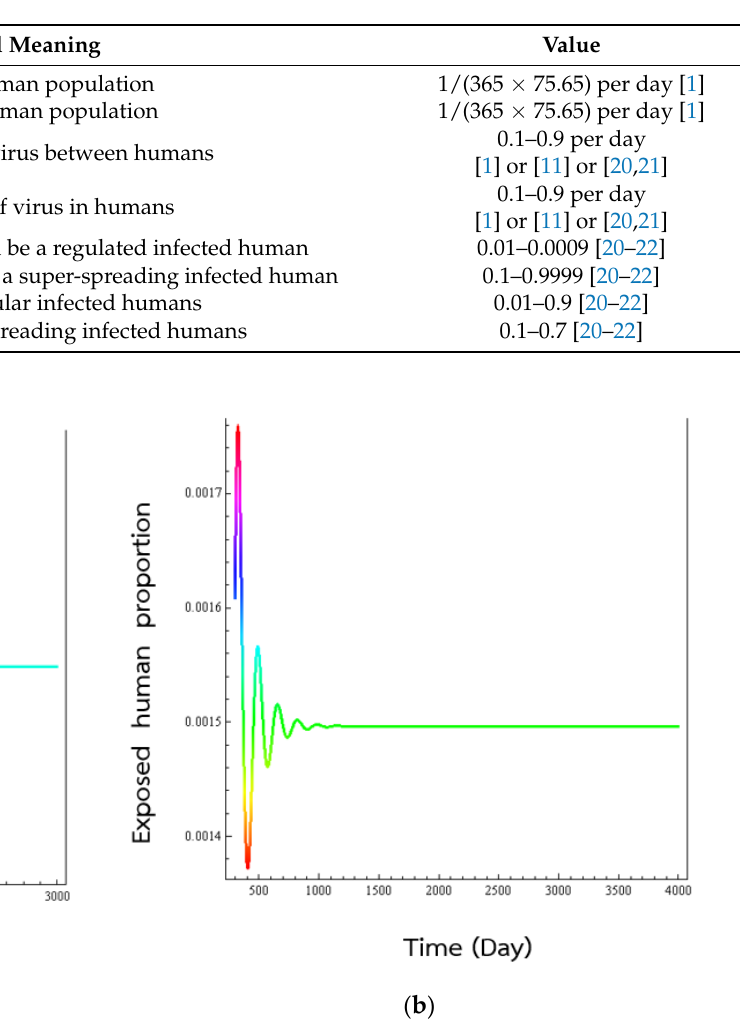
Table 1. Parameters used in simulation for this model.